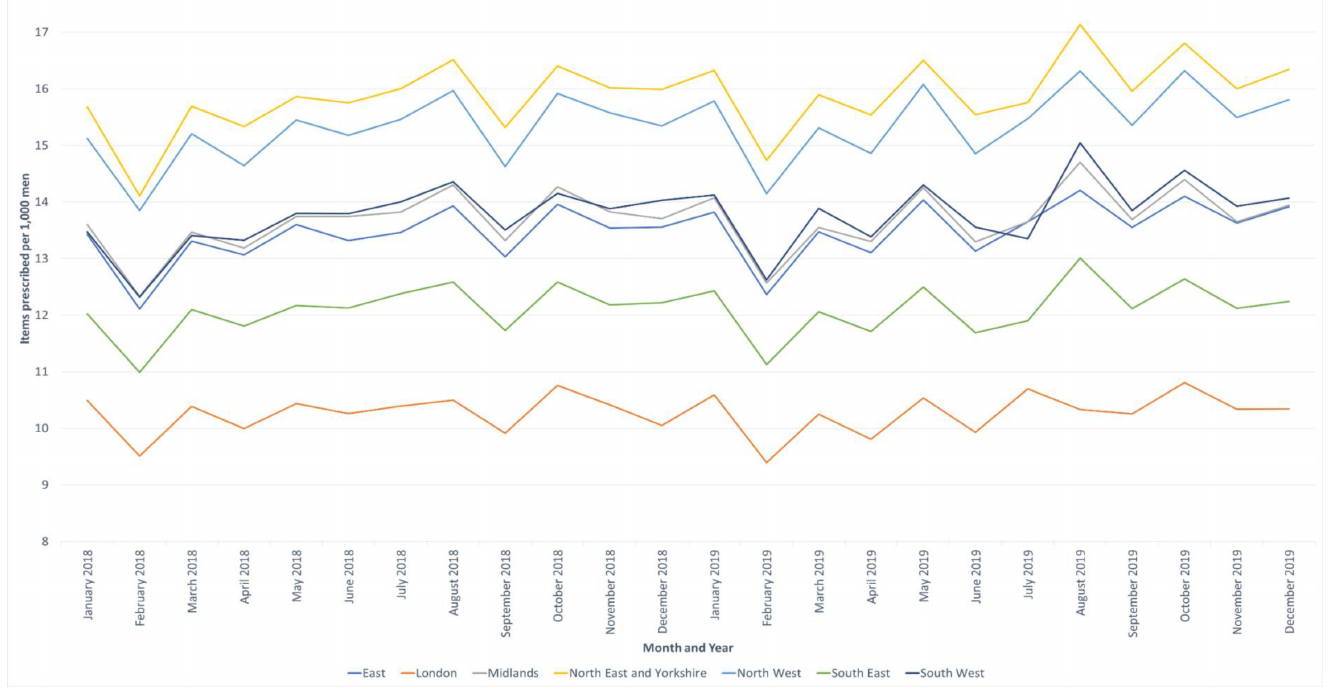
Figure 3 The number of erectile dysfunction medicine items prescribed per month in each NHS commissioning region in 2018 and